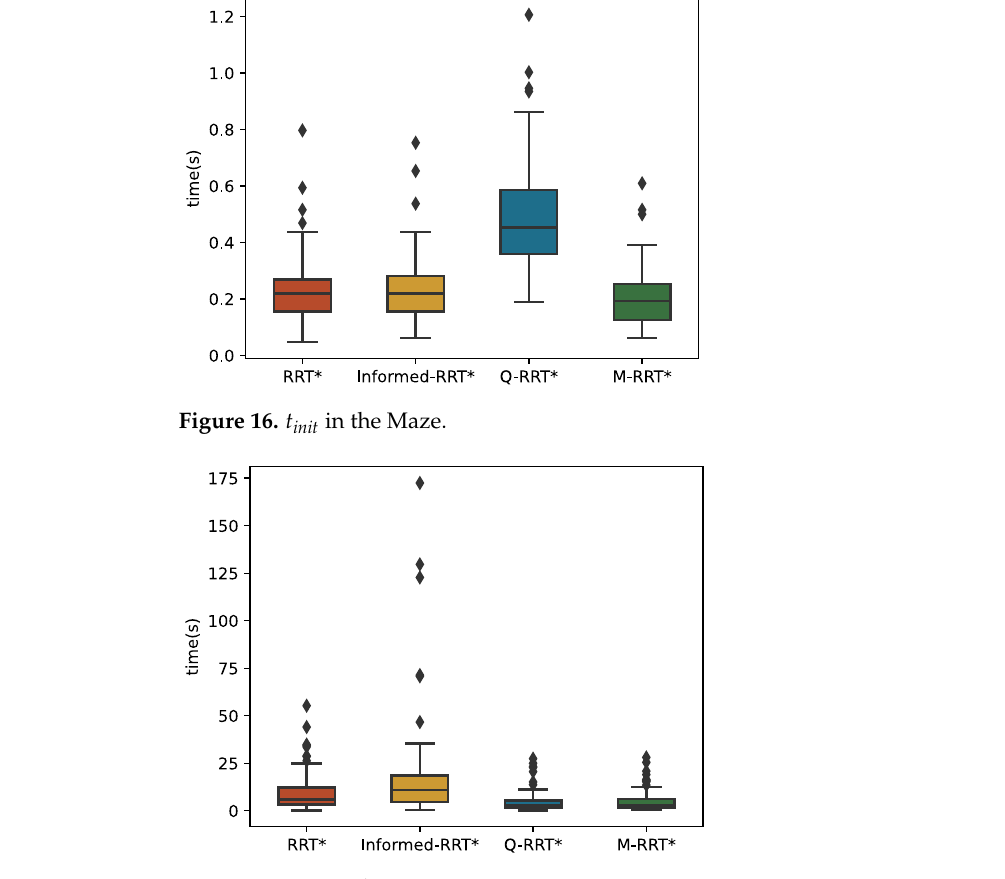
Figure 17. T 5% in the Maze. Table 4. t init and T 5% of four algorithms in the Maze.